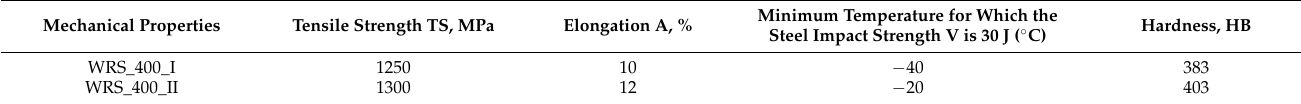
Table 3. Mechanical properties of the tested